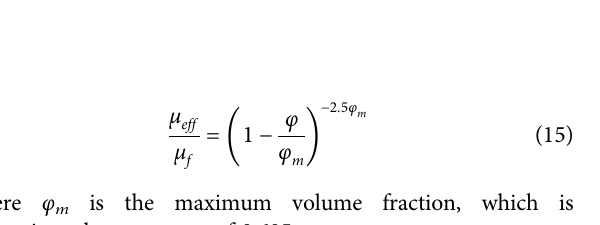
FIGURE 7 | Different models used to predict the change in the nano fl uid viscosity with particle concentration (T (cid:2) 600 K).